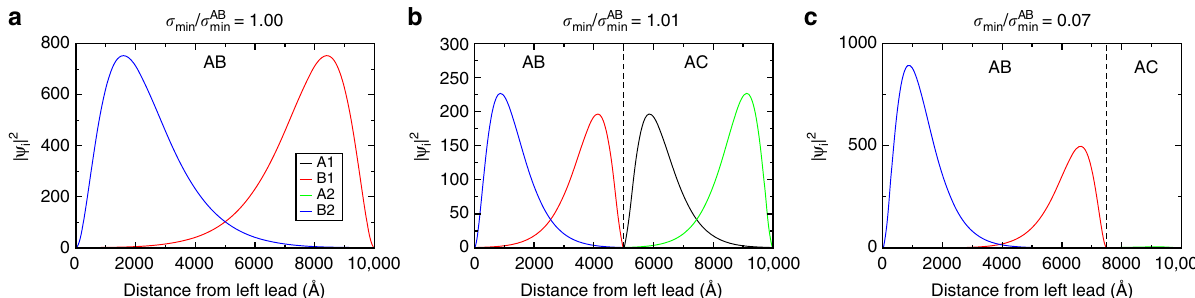
Fig. 2 Transport states | Ψ i ( x ) | 2 at the Dirac point. The vertical lines represent the positions of the partial dislocations, which can be seen to determine the basic structure of the wavefunction, while the line colour refers to the sublattice projection as indicated by the legend in a . Shown are: a the dislocation free bilayer, b conducting and c insulating states in a single partial con fi guration. Signi fi cant amplitude of | Ψ i ( x ) | 2 occurs only on the non-bonding sublattices, which are B1 and B2 for the AB stacked geometry, and A1 and A2 for the AC